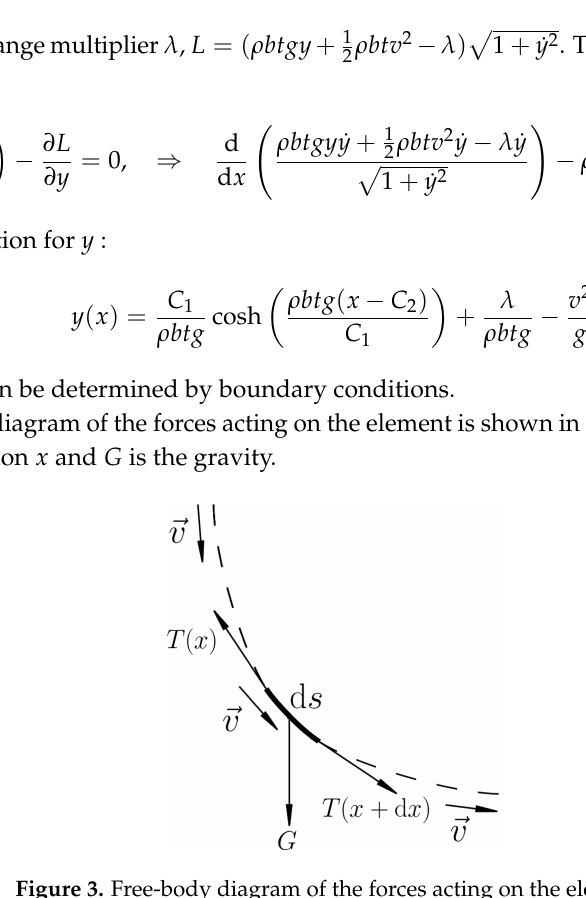
Figure 3. Free-body diagram of the forces acting on the